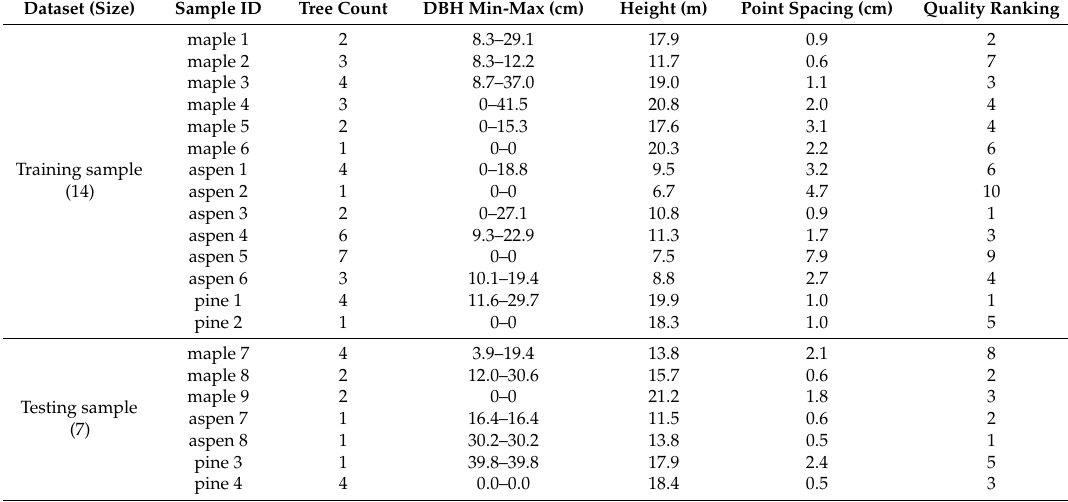
Table 1. Quantitative characteristics of each training and testing sample. DBH min-max means minimum and maximum DBH extracted from sample point clouds at a height of 1.3 m. A DBH with 0 value means unmeasurable. Height means vertical distance between lowest and highest points. Point spacing means median nearest neighbor distance. Quality ranking is described in Table